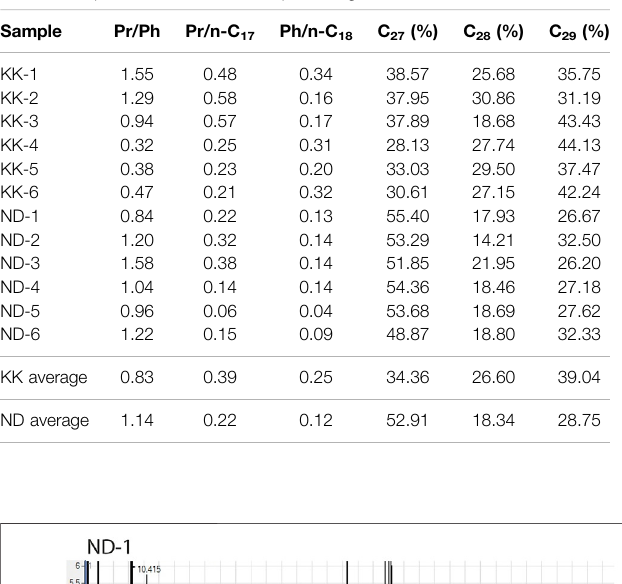
Frontiers in Earth Science |